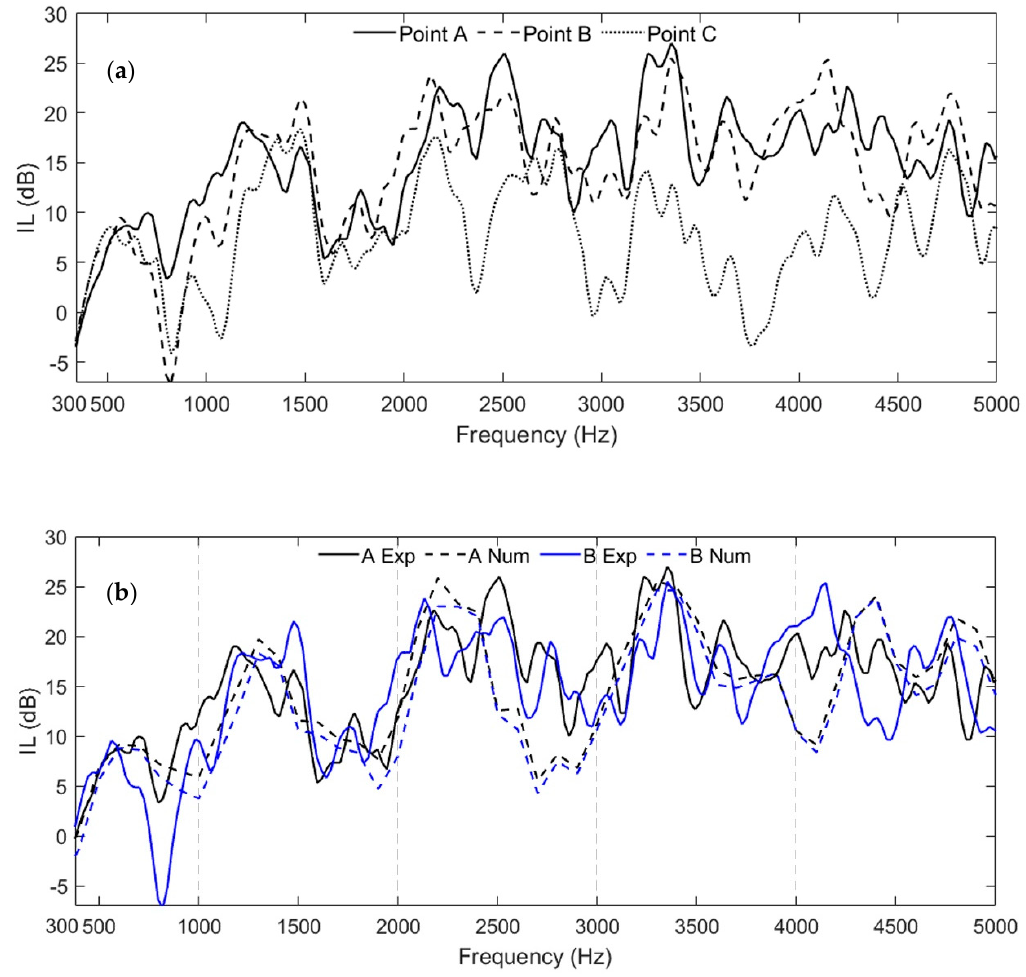
Figure 3. ( a ) Experimental analysis results in terms of IL related to measurement points A, B, and C. ( b ) Comparison of IL results related to the numerical and experimental studies on Points A and B. Six peaks are distributed along the overall range, where the first is between 300 and 1000 Hz, the second between 1000 and 2000 Hz, the third between 2000 and 3000 Hz, the fourth between 3000 and 4000 Hz, and the fifth and sixth between 4000 and 5000 Hz.